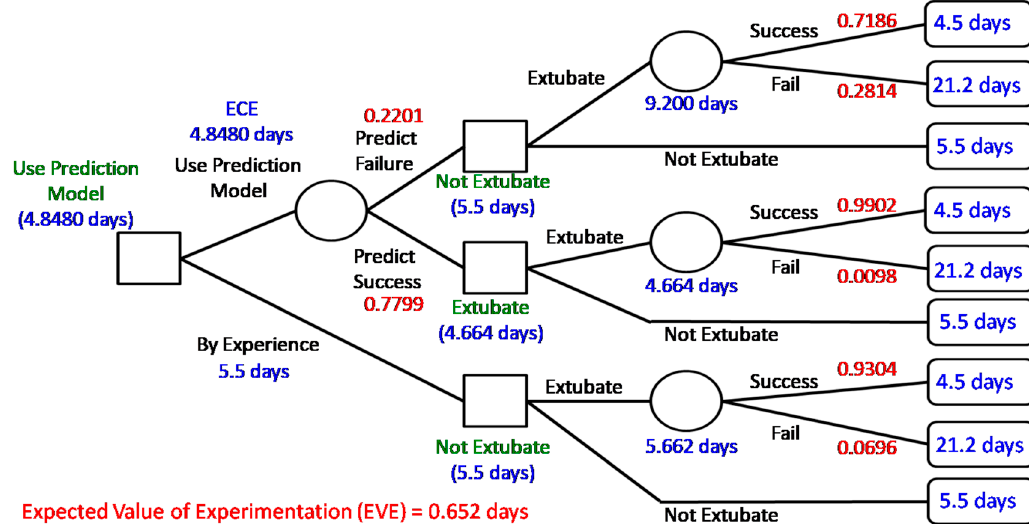
Figure 2. Results of Bayesian decision analysis and value of information.